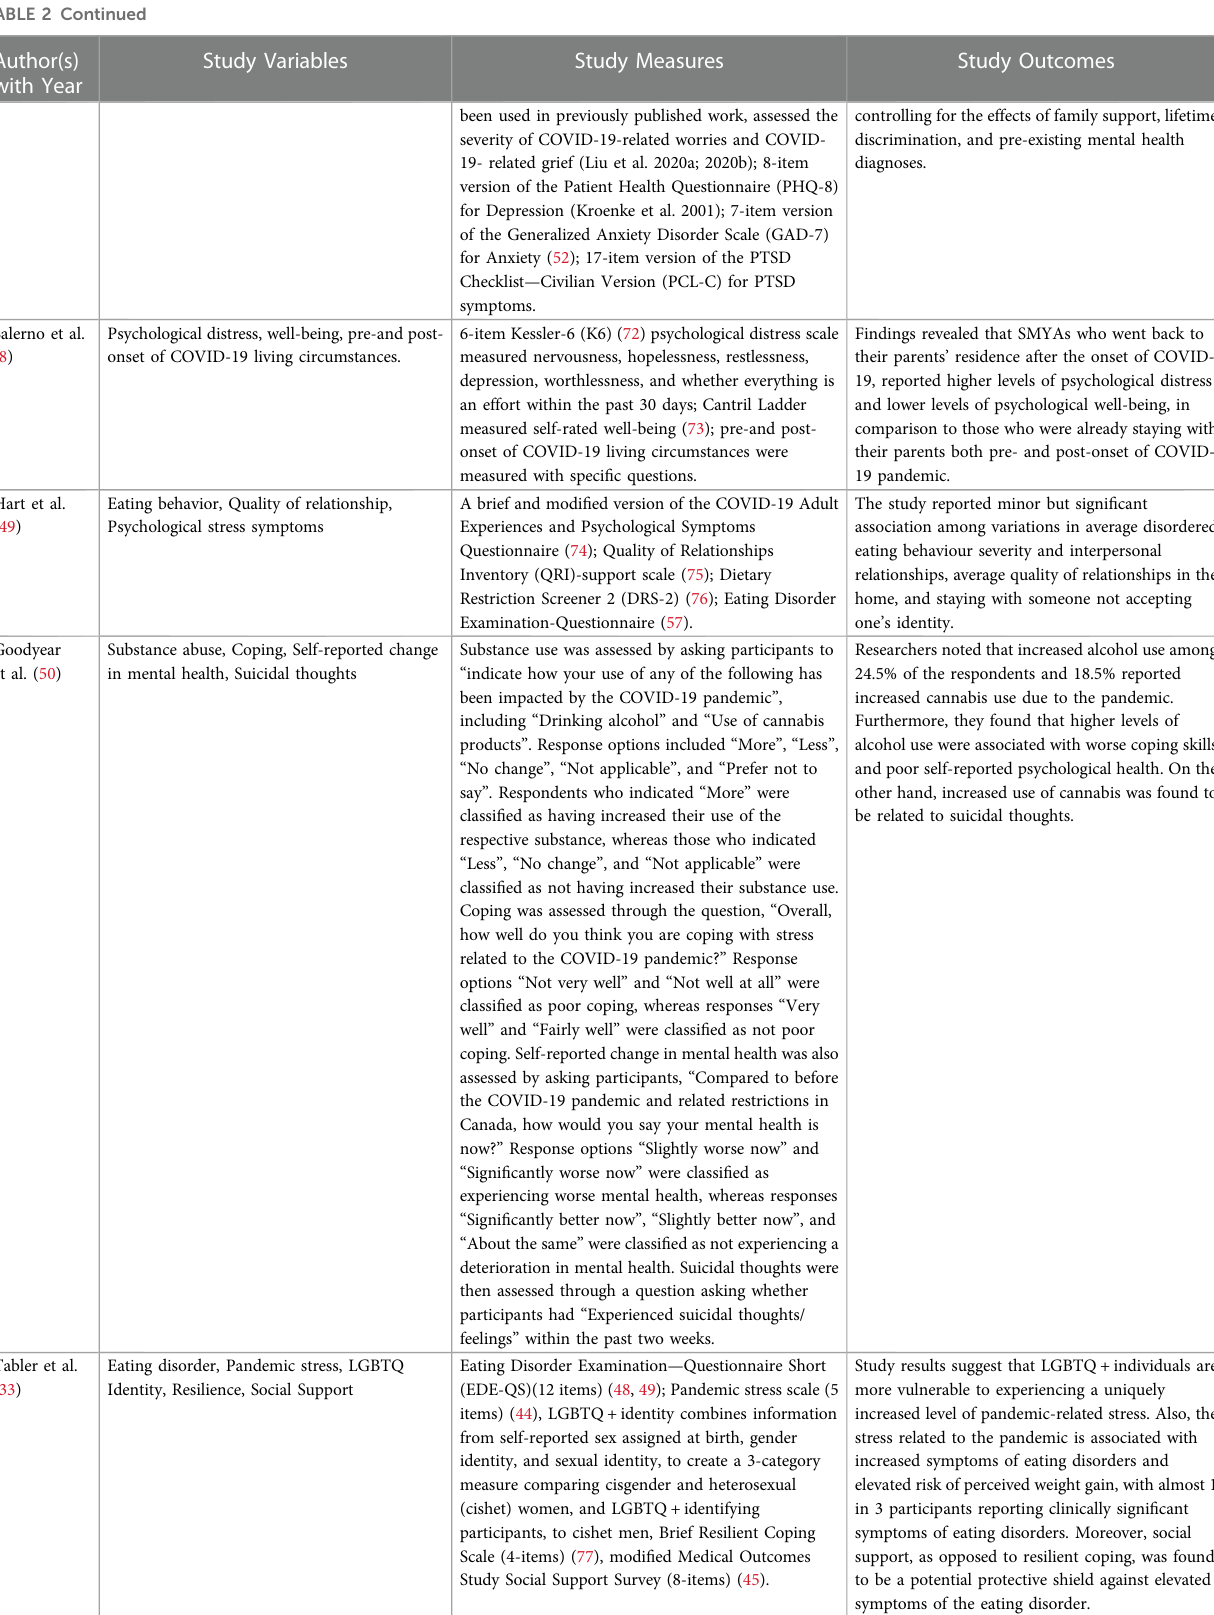
Eating disorder, Pandemic stress, LGBTQ Identity, Resilience, Social